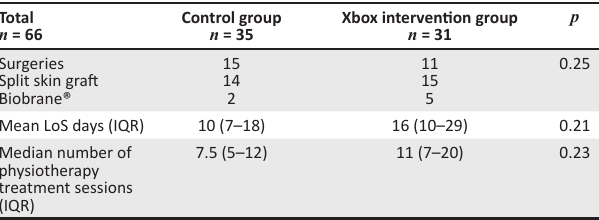
TABLE 2: The number of surgeries, length of stay and the number of physiotherapy treatment sessions for the study population ( n = 66).